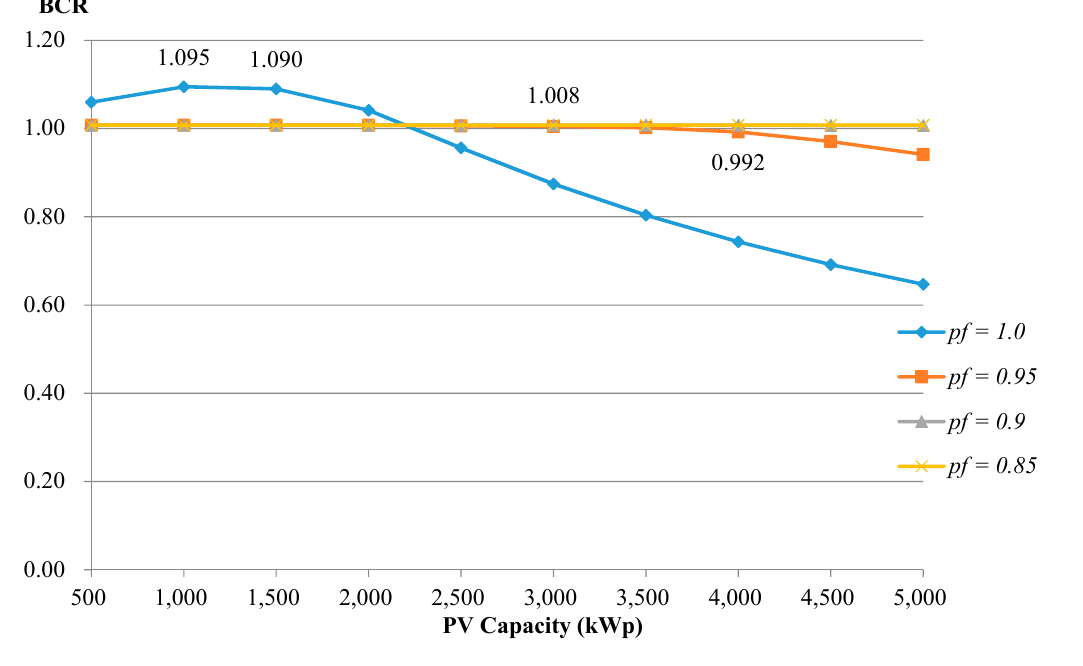
Figure 9. NPVs for control abilities pf = 1.0, 0.95, 0.9, and 0.85; NPV: net present value.